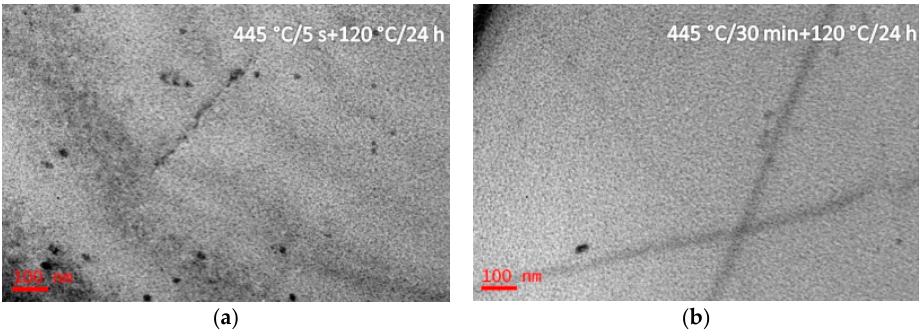
Figure 8. BF images of the studied alloy having been isothermal heat treated at 445 °C for different durations (5 s and 30 min), and then aged at 120 °C for 24 h. The isothermal heat treatment durations are: ( a ) 5 s; ( b ) 30 min.